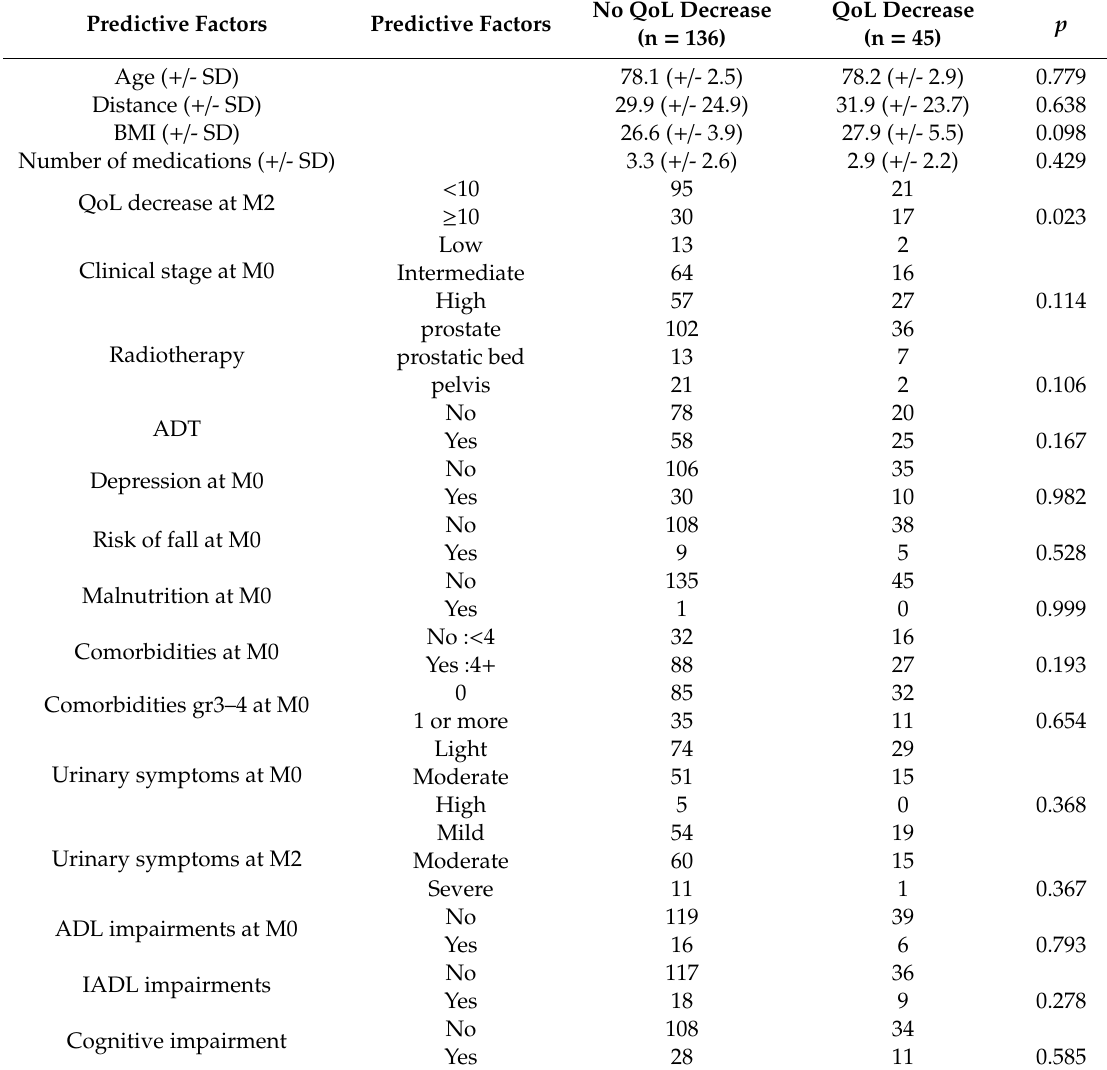
Table 3. Predictive factors for changes ≥ 10 points in quality of life scores at M6 /